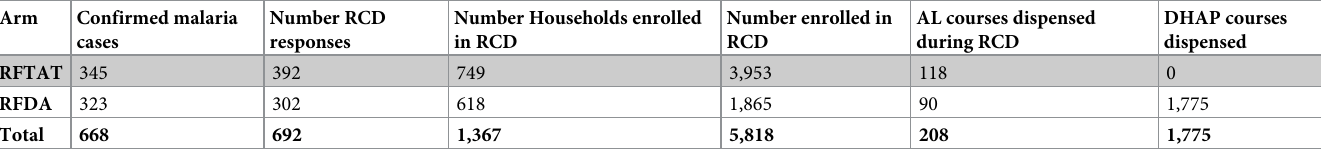
Table 1. Number of individuals enrolled and treated in the CoRE study by arm.